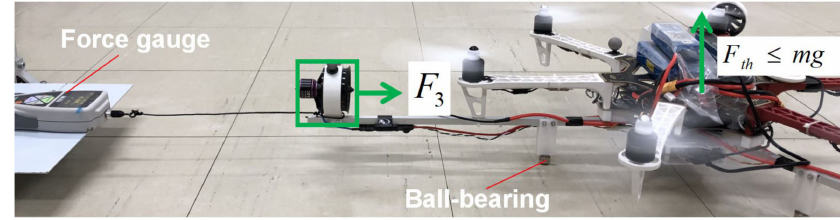
Figure 5. Experimental set up for force measurement.